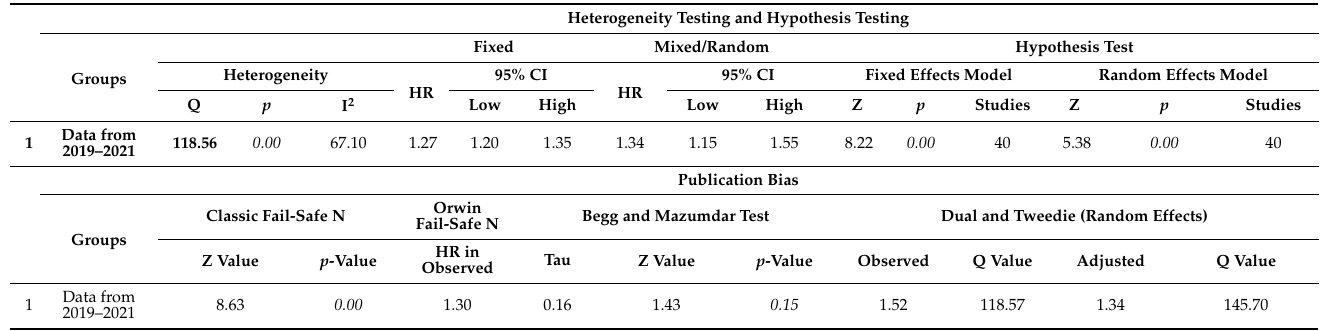
Table 5. Publication bias indicators and hypothesis testing and heterogeneity testing analysis of miRNA-specific chemoresistance in